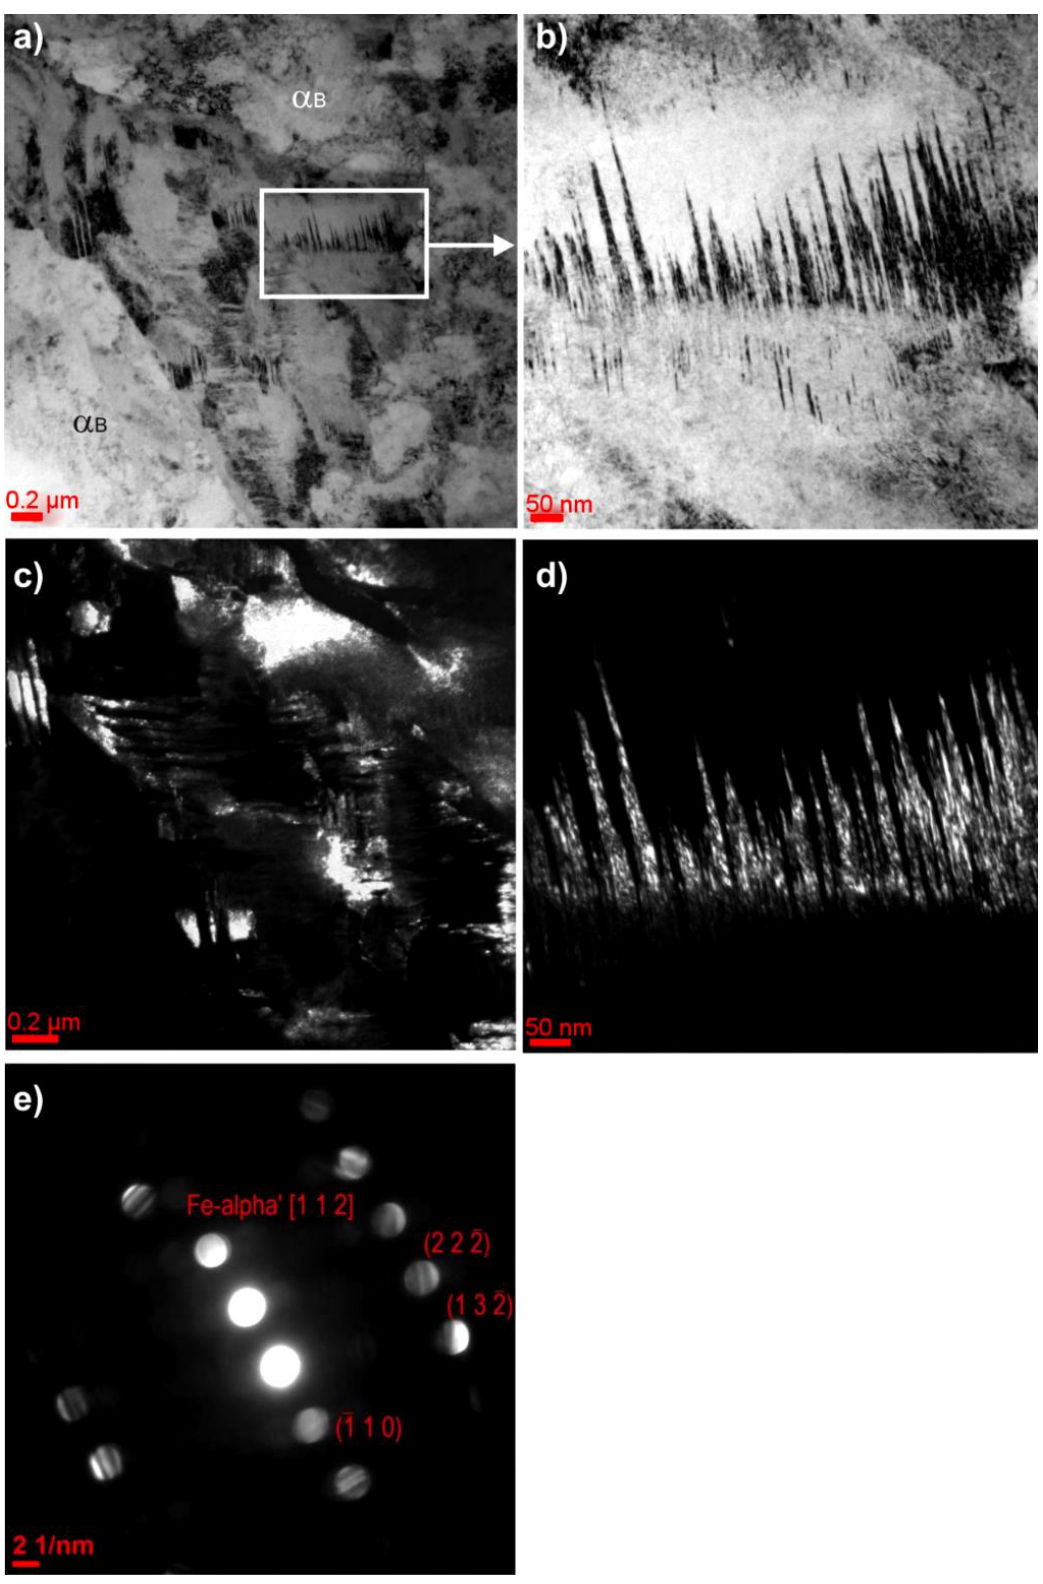
Figure 10. Blocky grain of retained austenite partially transformed into martensite in 3Mn-1.5Al steel ( a ) bright field, ( b ) magnification of the fragment from ( a ), ( c ) dark field from retained austenite, ( d ) dark field from martensite (132) , ( e ) microdiffraction solution from the martensitic plates area.